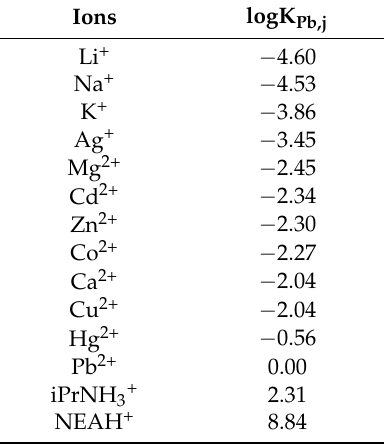
Table 2. Potentiometric selectivity of the PVC-based electrode membrane containing ligand rac - 4 and DOS as a plasticizer for different metal ions and protonated primary amines.